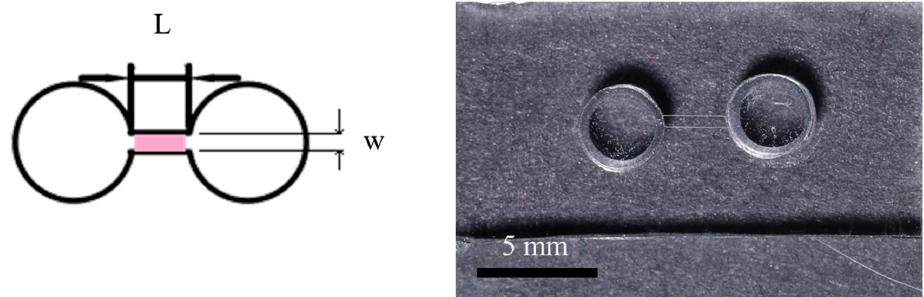
Figure 2. Basic configuration and photograph of the reverse electrodialysis (RED)